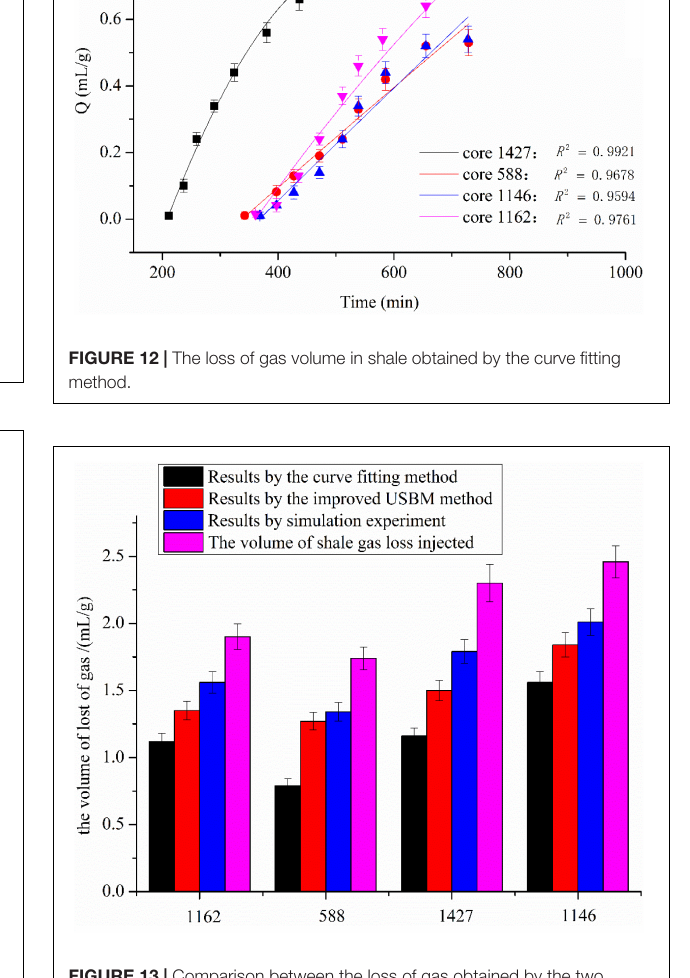
Figure 11 . And the volume of shale gas loss obtained by the curve fitting method were 1.12, 0.79, 1.16, and 1.56 ml/g. As showed